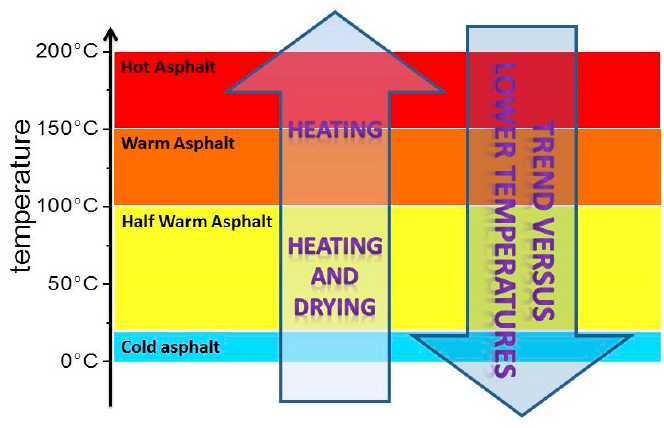
Figure 1. Classification by temperature range.